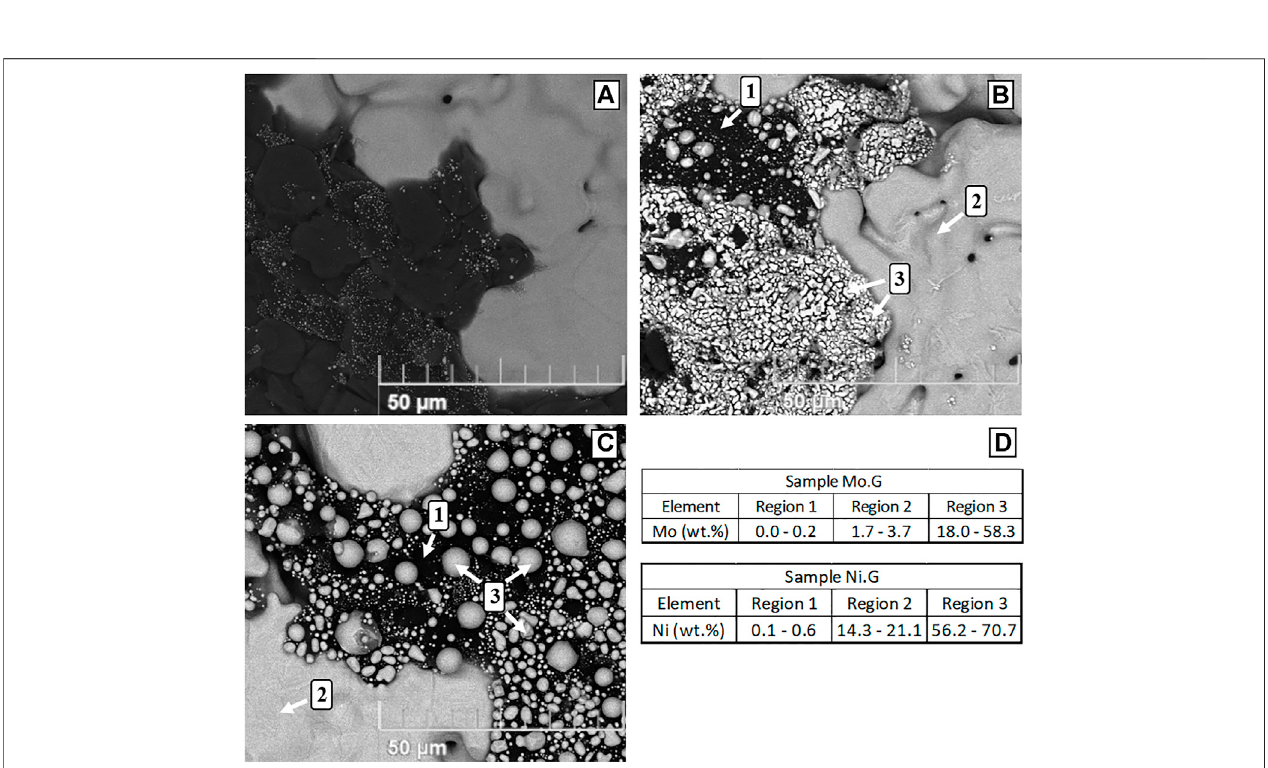
FIGURE 2 | SEM micrographs of typical surfaces (A) sample S.G – sintered only, (B) sample Mo.G – molybdenum-enriched, (C) sample Ni.G – nickel-enriched, and (D) EDS analysis results.